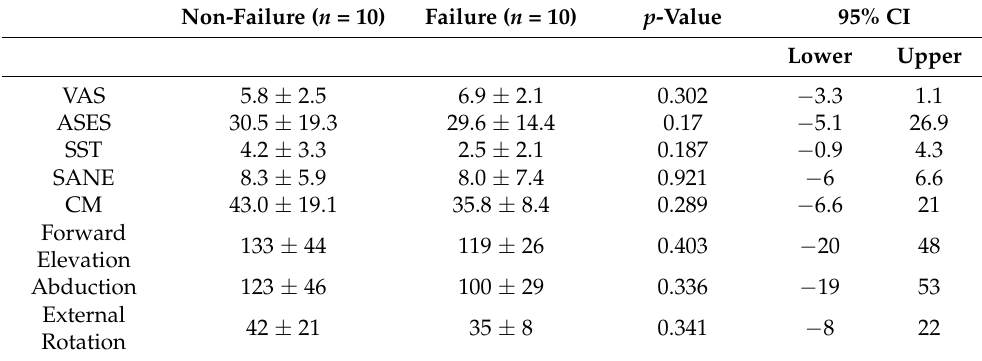
Table 2. Pre-operative Pain and Functional Measurements.